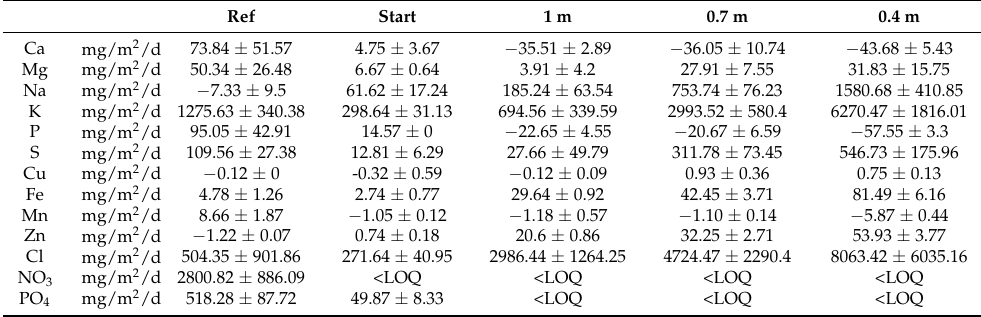
Table A8. The measured nutrient removal in the simulated system, during cultivation ± standard deviations (LOQ stands for limit of quantification). ’Start’ = the composition of the growing medium of a continuous system at the start of the growing season; ’1 m’/’0.7 m’/’0.4 m’ = the composition of the growing medium of a continuous system after 175 days of cultivation in a 1 m/0.7 m/0.4 m deep